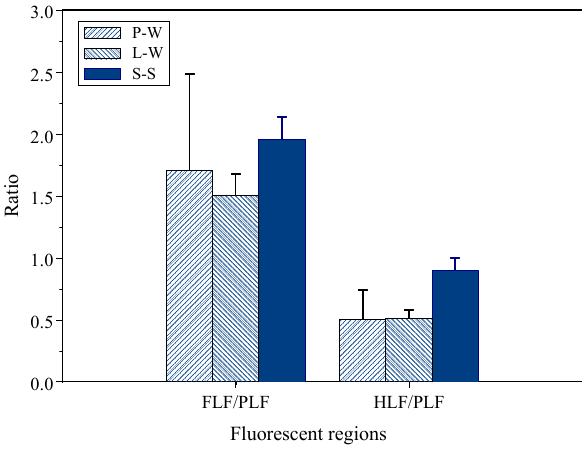
Figure 4. The OCS FLF / PLF and OCS HLF / PLF ratios for P-W, L-W and S-S.